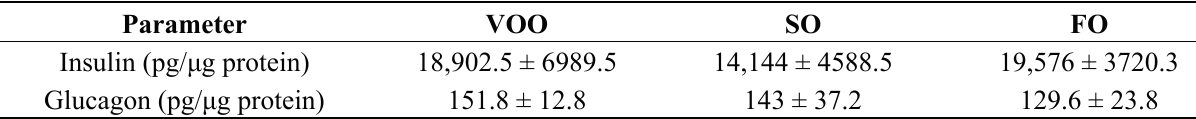
Table 2. Total insulin and glucagon pancreatic contents in rats fed on CoQ supplemented diet based on virgin olive oil (VOO), sunflower oil (SO) and fish oil (FO) at the end of the experimental